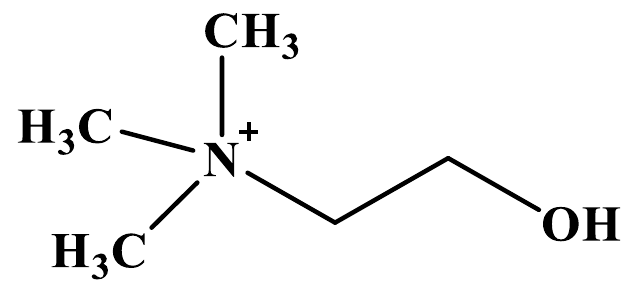
Figure 1. Chemical structure of choline.